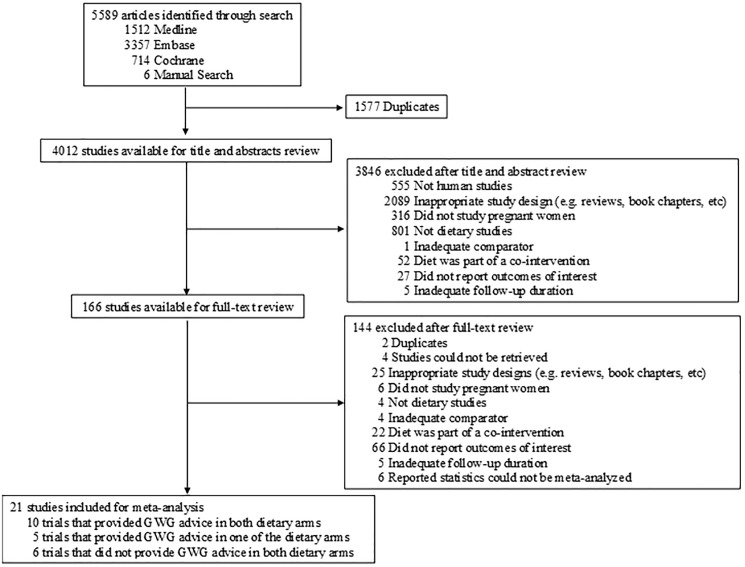
Flow of the literature search.